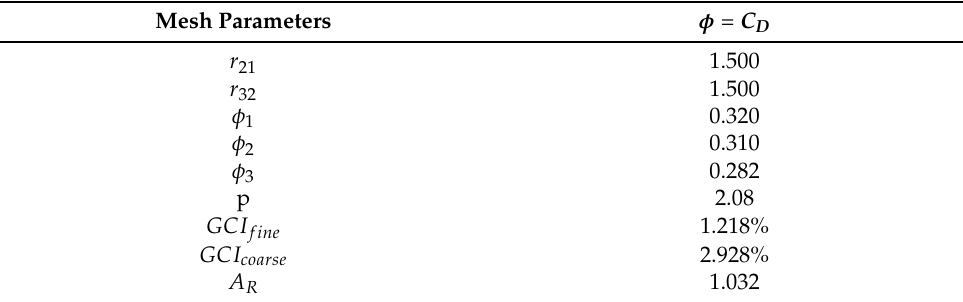
Table 1. Grid convergence indexes of the three meshes